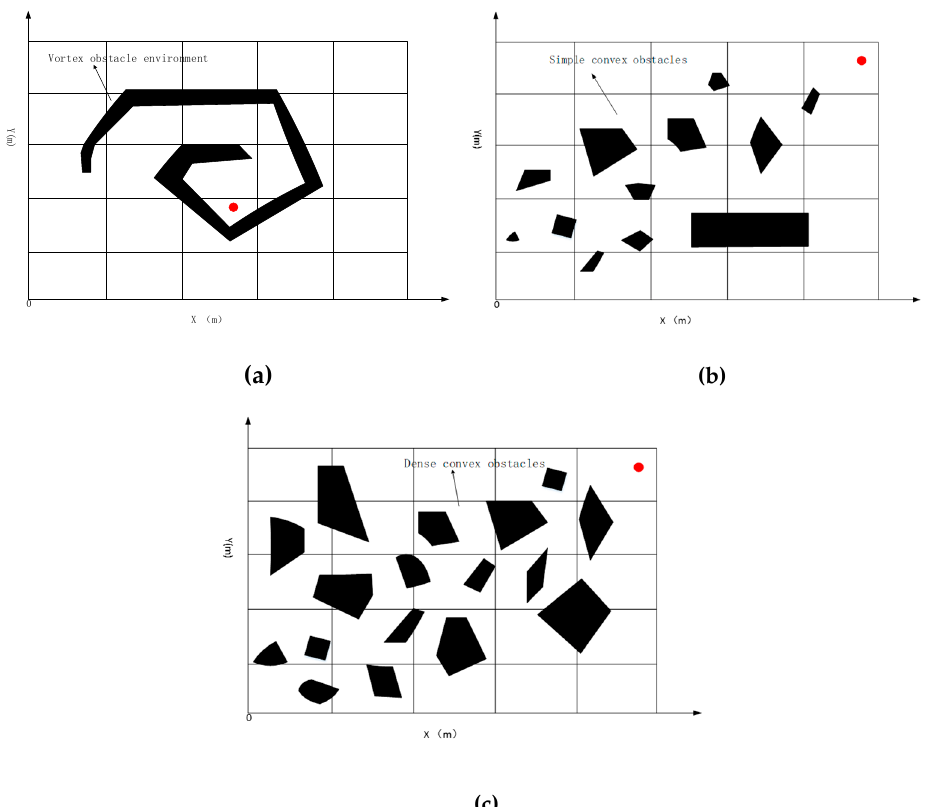
Figure 2. Different types of obstacles. ( a )No-Convex Obstacles. ( b ) Simple convex obstacle environment. ( c ) Dense Convex Obstacles.